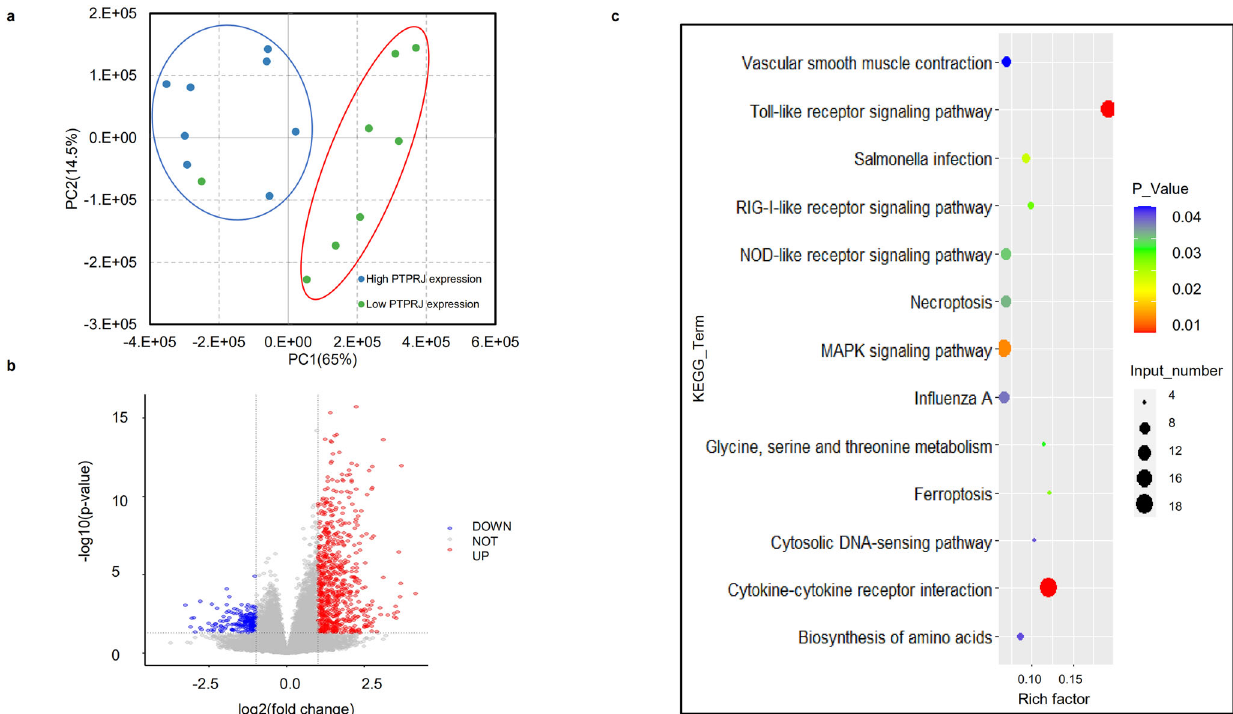
Fig. 5 Gene expression pro fi les of heterophils from individuals grouped by PTPRJ expression level. a RNA-seq analysis and identi fi cation of genes differentially expressed between different groups of chicks. PCA was performed on the RNA-seq data for all genes identi fi ed in heterophils. b Volcano plot showing DEGs. Red dots represent signi fi cantly upregulated genes (|log2 FC| ≥ 1 and P < 0.05); blue dots represent signi fi cantly downregulated genes; and gray dots represent genes with no signi fi cant change. c Pathways enriched in DEGs. The y axis represents all signi fi cantly enriched pathway terms in DEGs. The x axis represents rich factors as de fi ned by the degree of DEG enrichment (number of DEGs in term/number of all genes in term). Color represents signi fi cance, and bubble size represents the number of DEGs in the pathway.